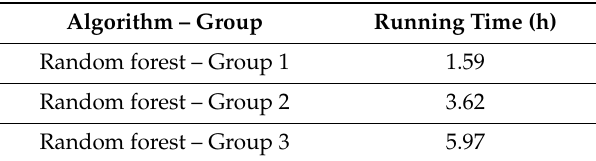
Table 12. Computational power recorded for three groups of predictors (Figure 3) used in the Random Forest model.